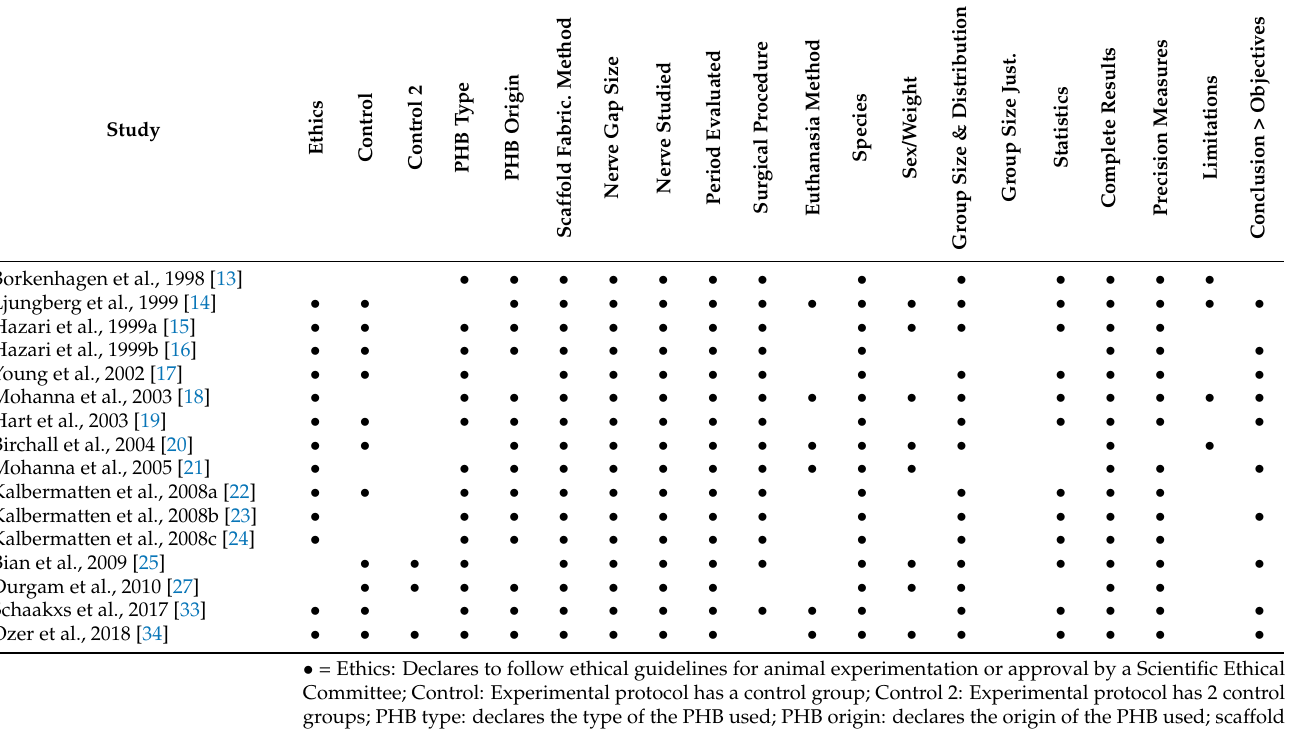
Table 2. Quality analysis of animal studies using ARRIVE guidelines [41] adapted for nerve regener- ation treated with PHB